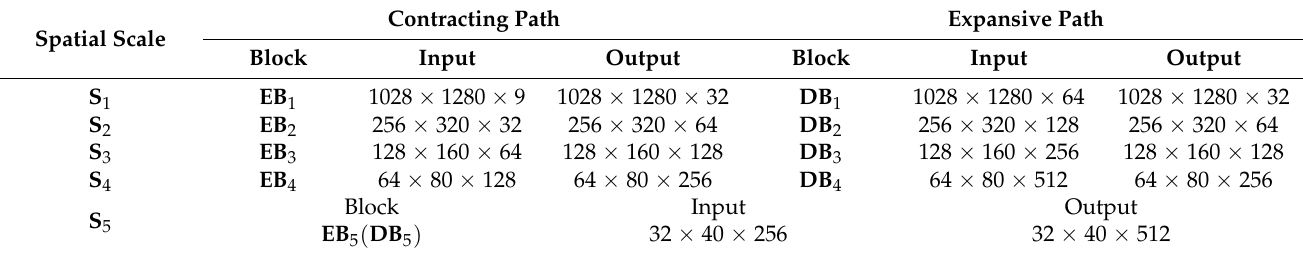
Figure 3. The detailed layer configuration of the designed FCN. Table 1. The dimensions of feature maps in different spatial scales.